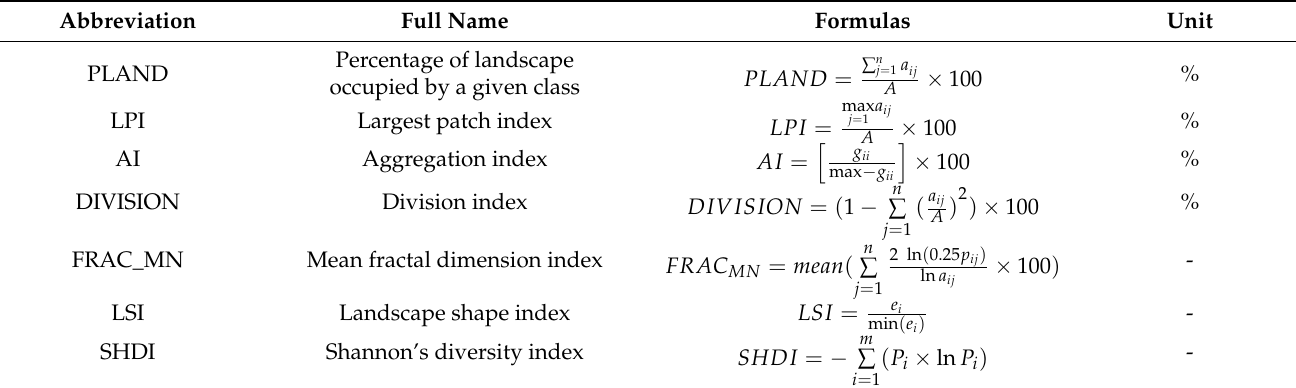
Table 2. Calculated landscape